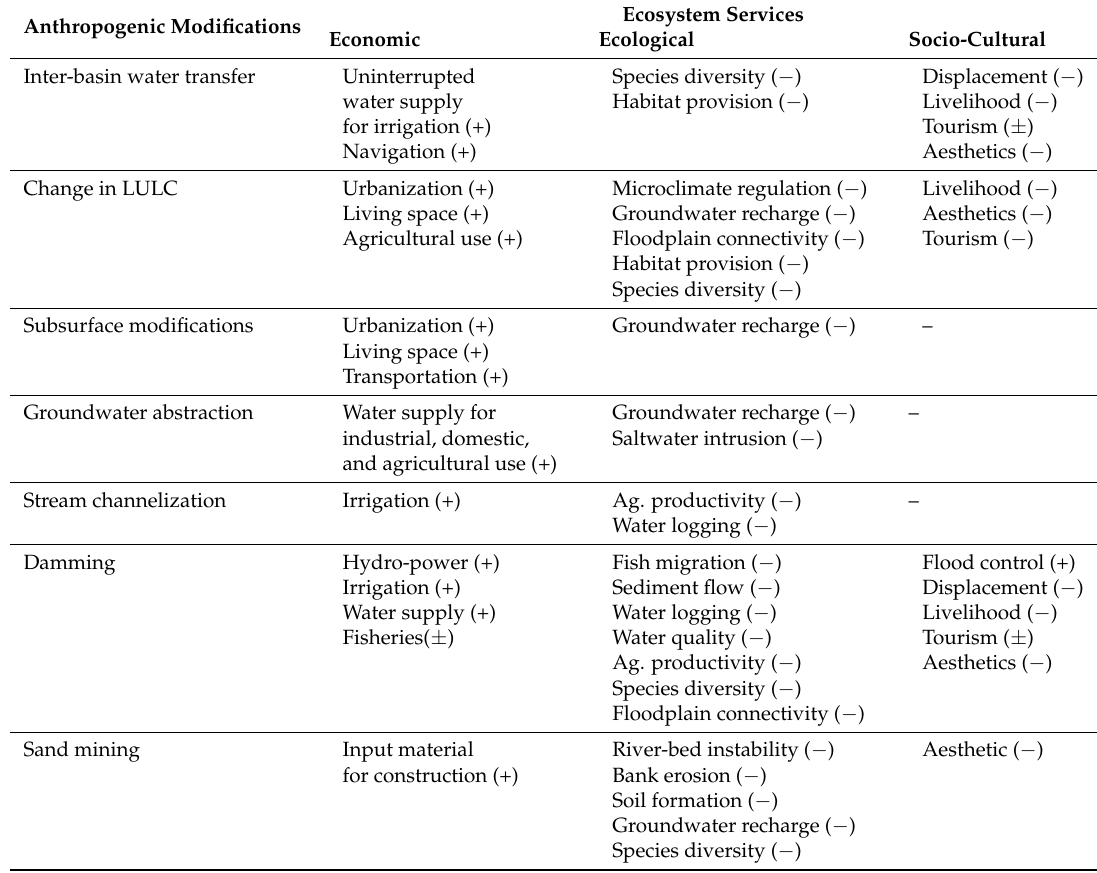
Table 5. Influence of river-landscape modifications on economic, ecological, and socio-cultural ES aspects. The signs (+) and ( − ) indicate positive and negative influence on ecosystem services,